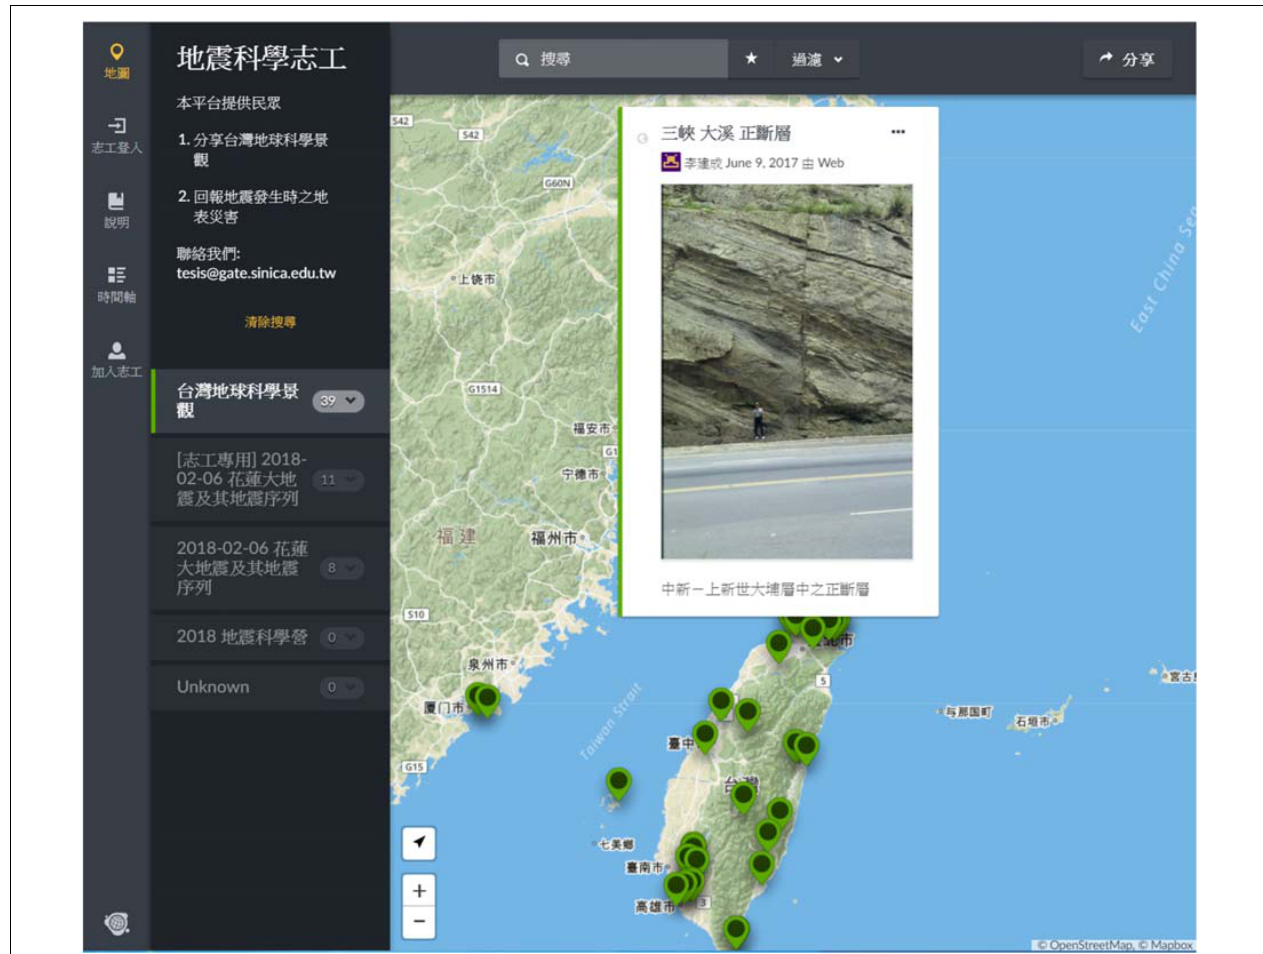
FIGURE 5 | An example illustrating a geological landscape reported in the TSER system. The information includes name of the landscape feature (normal fault), location, post by whom and date, the associated photography or image, and descriptions of the key features in